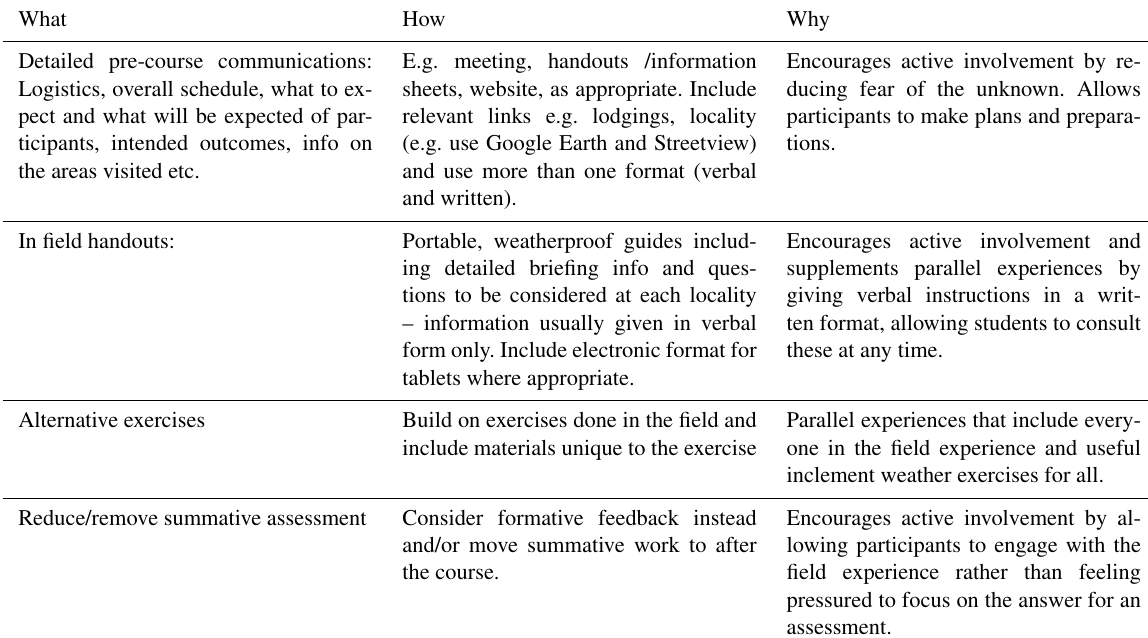
Table 2. Key mitigations and how and why to make them. What How Why Detailed pre-course